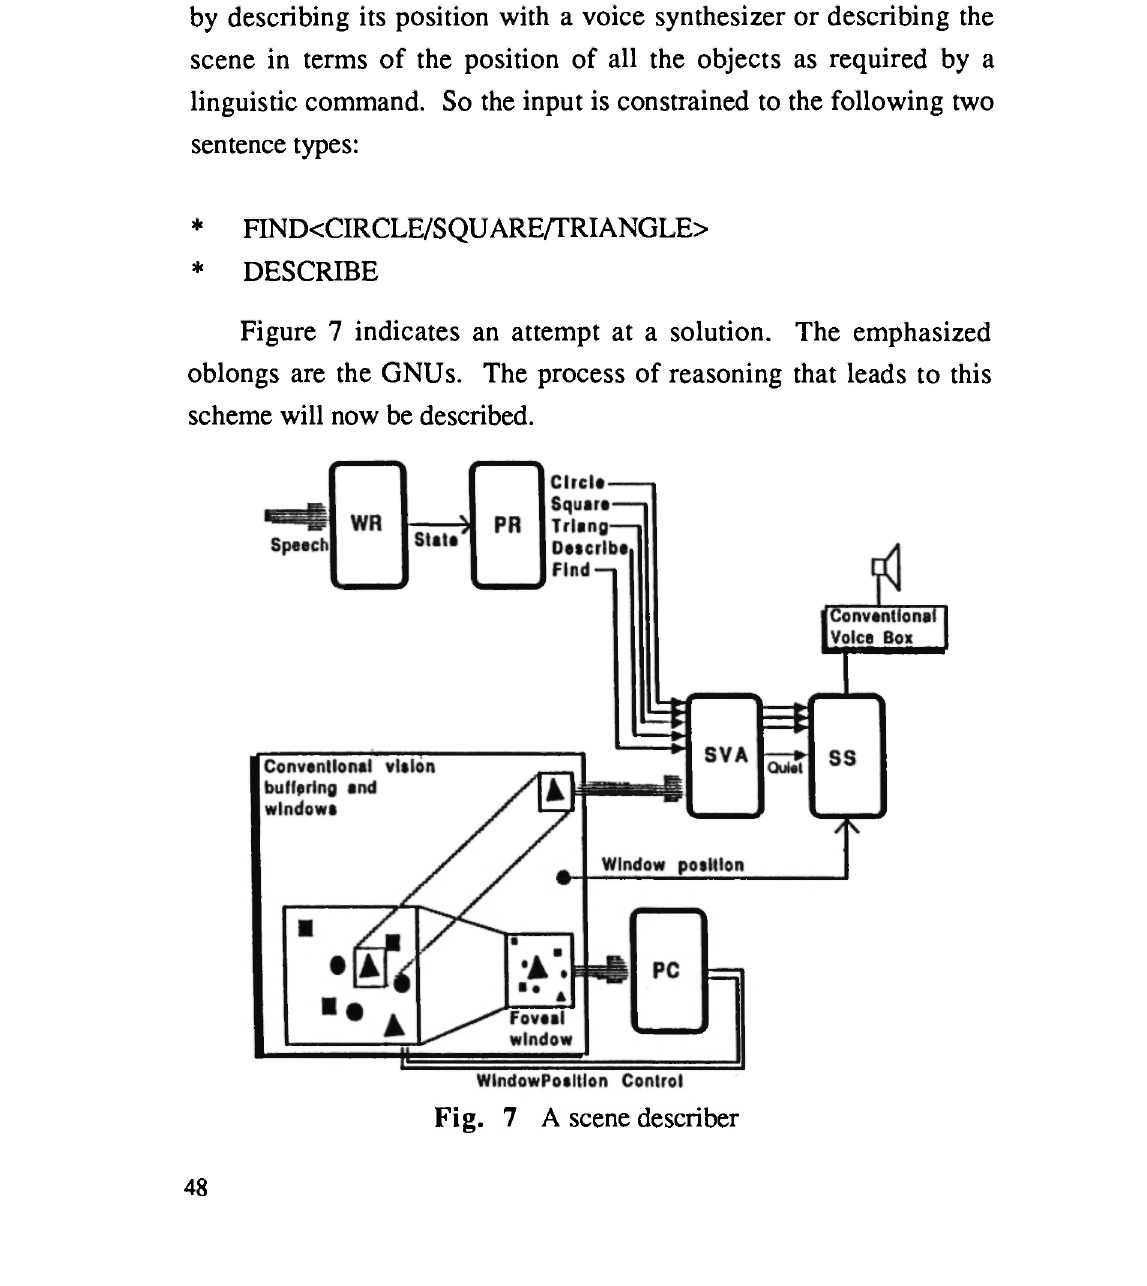
Figure 7 indicates an attempt at a solution. The